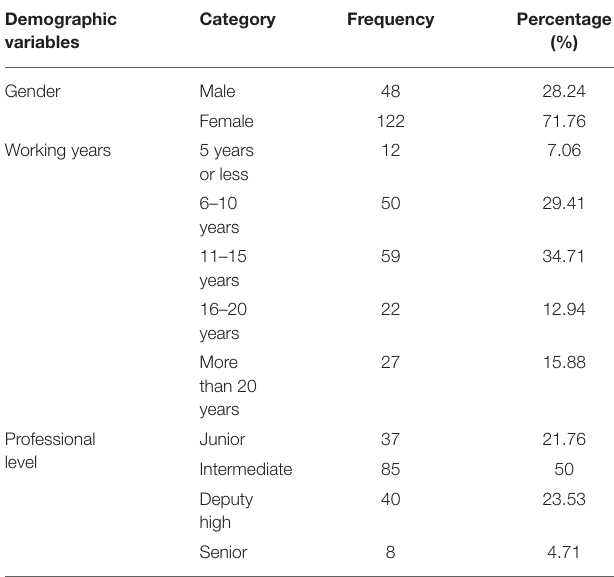
TABLE 1 | Demographic characteristics of the medical